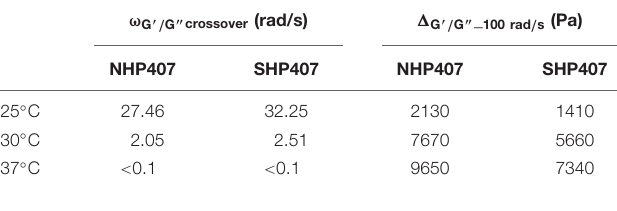
TABLE 1 | Frequency values at G (cid:48) /G (cid:48)(cid:48) crossover ( ω G (cid:48) / G (cid:48)(cid:48) crossover ) and G (cid:48) /G (cid:48)(cid:48) delta at 100 rad/s ( (cid:49) G (cid:48) / G (cid:48)(cid:48) _ 100 rad / s ) for NHP407 and SHP407 hydrogels, evaluated at 25, 30, and 37 ◦